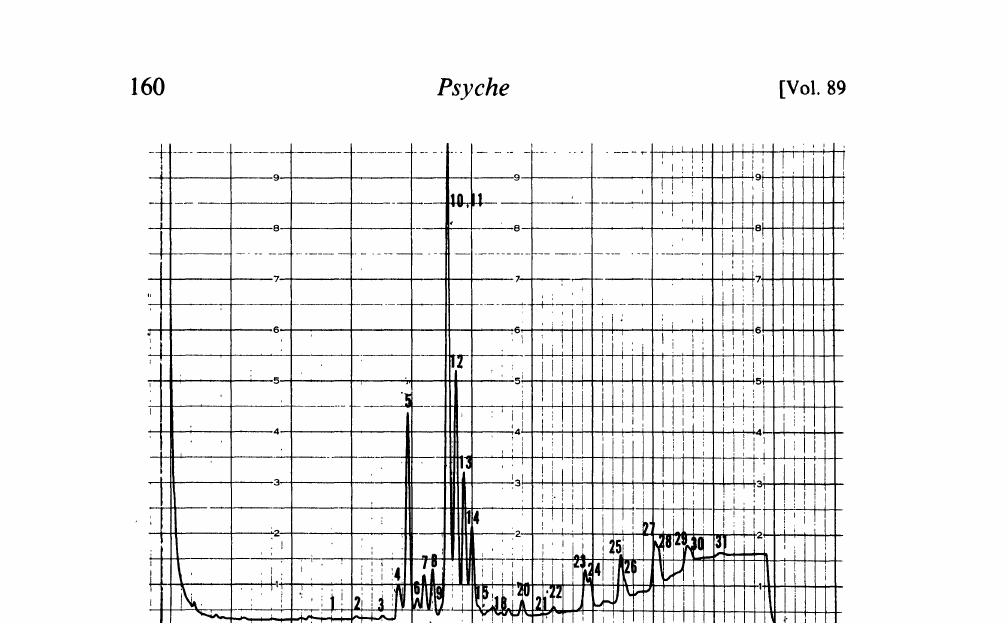
Fig I. GC trace of total cuticular hydrocarbons of Reticulitermes virginicus. GC conditions: 1.83 m 3 mm i.d. Stainless steel column packed with 3 percent (w/w) SP-2100 on 100! 120 mesh Supelcoport; temperature programmed from 150 to 325 C at 5 C/min.